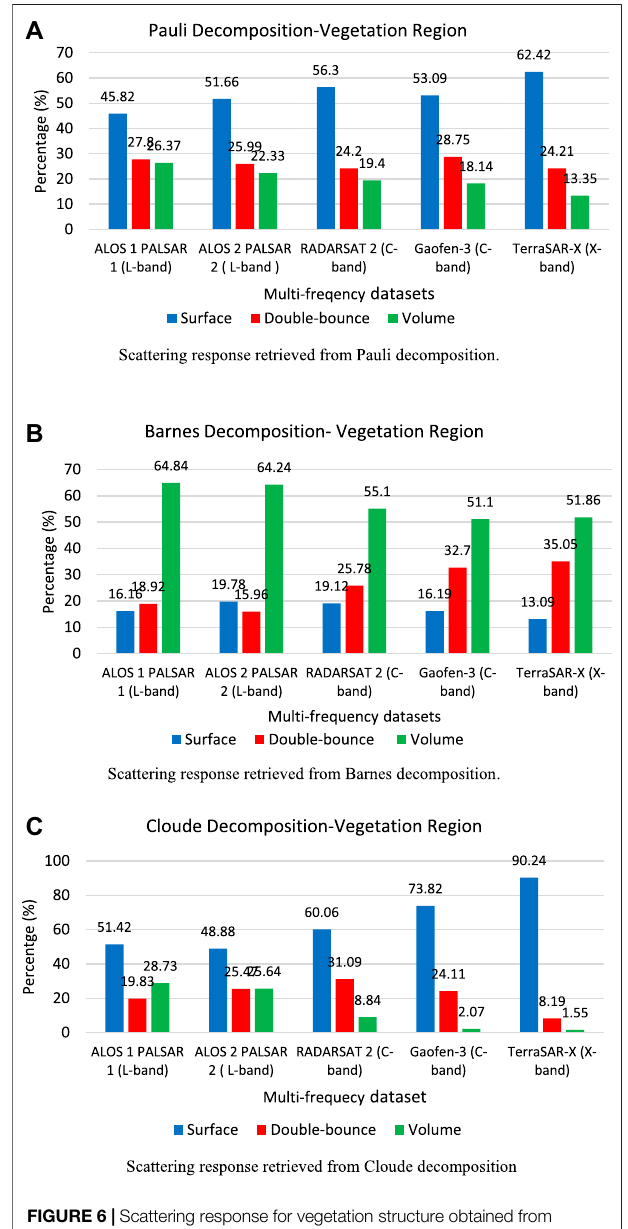
FIGURE 6 | Scattering response for vegetation structure obtained from Pauli, Barnes, and Cloude decomposition models. (A) Scattering response retrieved from Pauli decomposition. (B) Scattering response retrieved from Barnes decomposition. (C) Scattering response retrieved from Cloude decomposition.